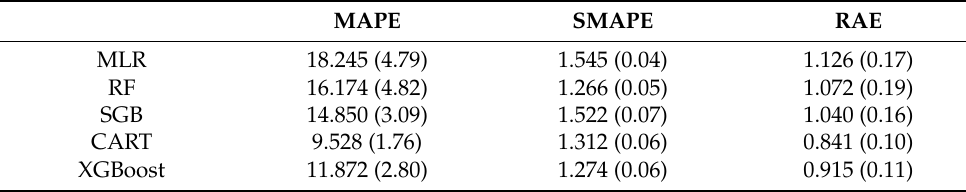
Table 4. The average performance of the MLR, RF, SGB, CART, and XGBoost methods. MAPE SMAPE